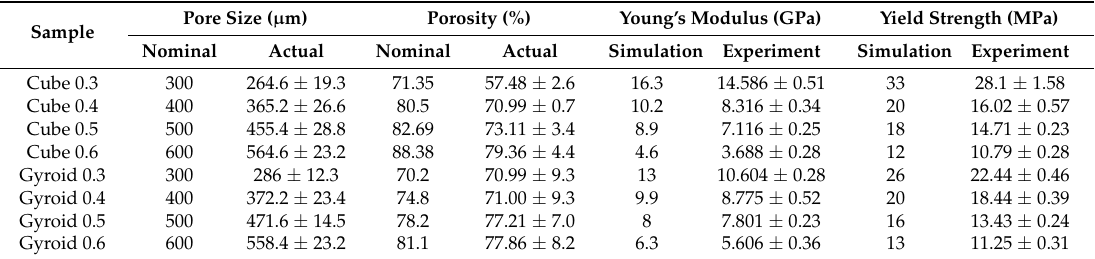
Table 2. Comparison of analyzed properties for cube and gyroid porous samples.